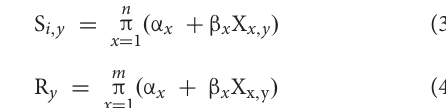
Juveniles Subadults Mature adults: